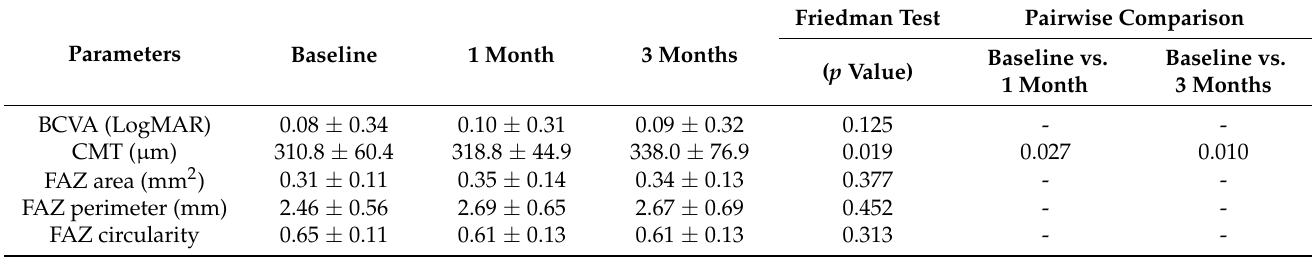
Table 3. Summary of the no DMI group results and comparison of the baseline and post-panretinal photocoagulation